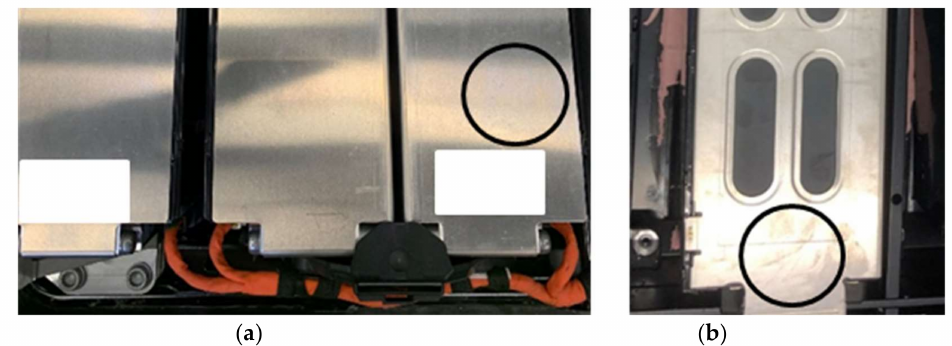
Figure 20. Presentation of VW module ( a ) and Audi e-tron module ( b ) with the respective measuring points (marked in black).